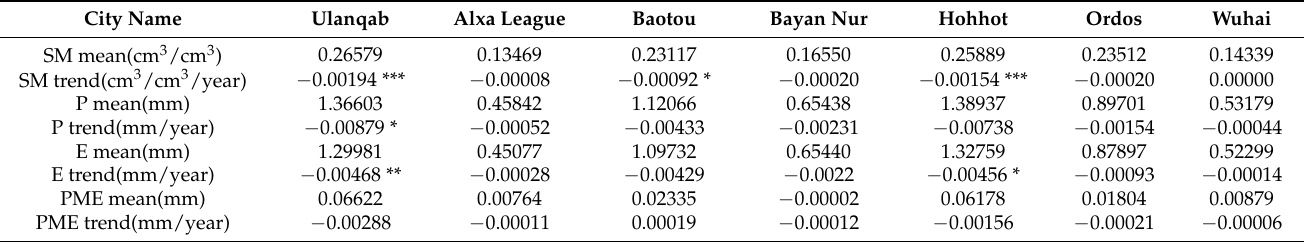
Table 2. Long-term monthly mean value and interannual trends in soil moisture (SM), precipitation (P), evapotranspiration (E) and precipitation minus evapotranspiration (PME). Sensitivity coefficient of 1 indicates that increases by 100% of its standard deviation when last month SM increases by one standard deviation. (* p < 0.05, ** p < 0.01, *** p <